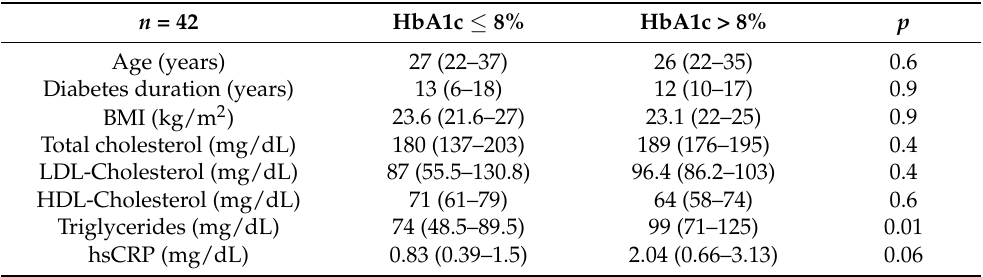
Table 2. Comparison of subgroups according to the median value of HbA1c in the study group. The Mann–Whitney U test.